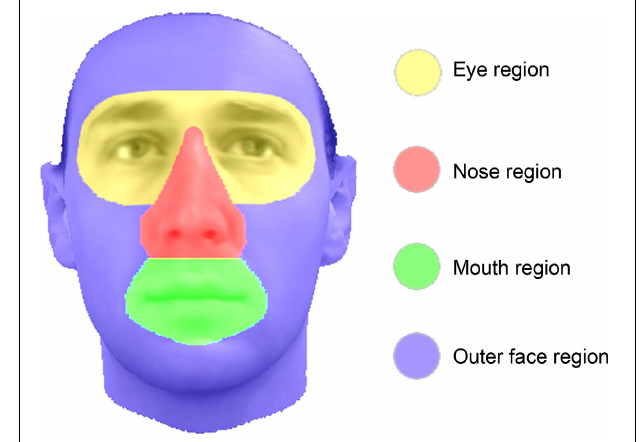
FIGURE 1 | Performance of the 3 participant groups in the CFMT. Data are displayed as mean percentage correct responses. Error bars: SEM.